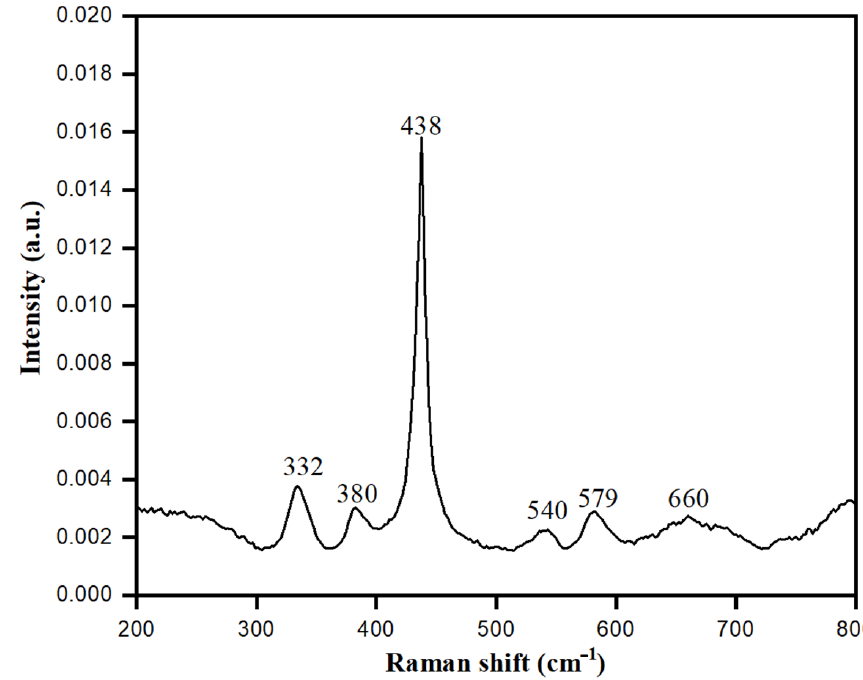
Figure 10. Raman spectra of bio ‐ fabricated ZnONPs.